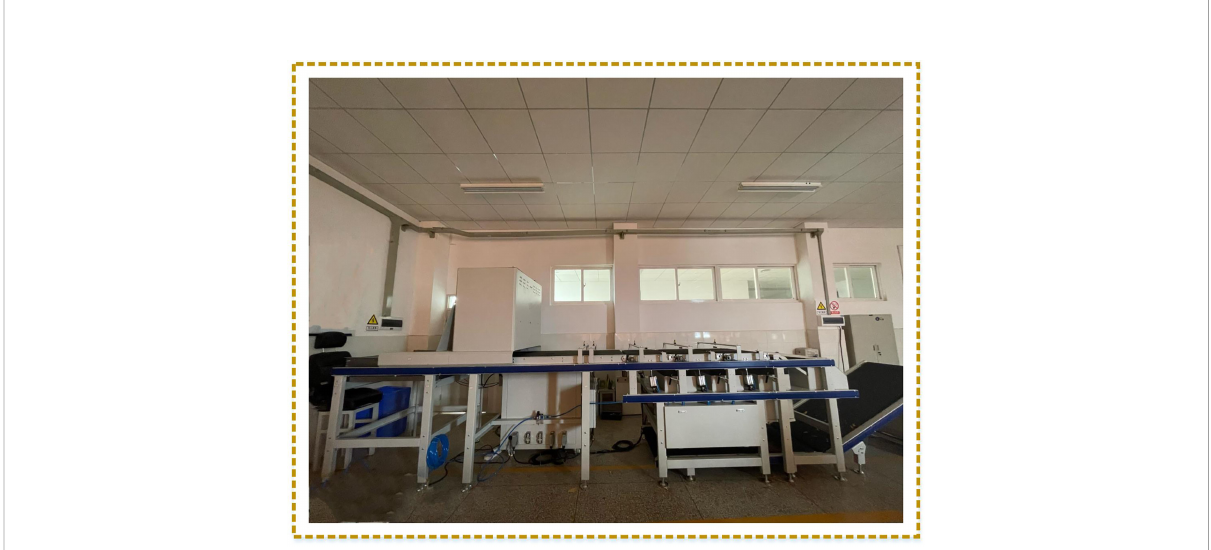
FIGURE 1 Professional acquisition machine for images. The image data collector consists of conveyor belts, industrial cameras, operating systems, sensors, collecting boxes,